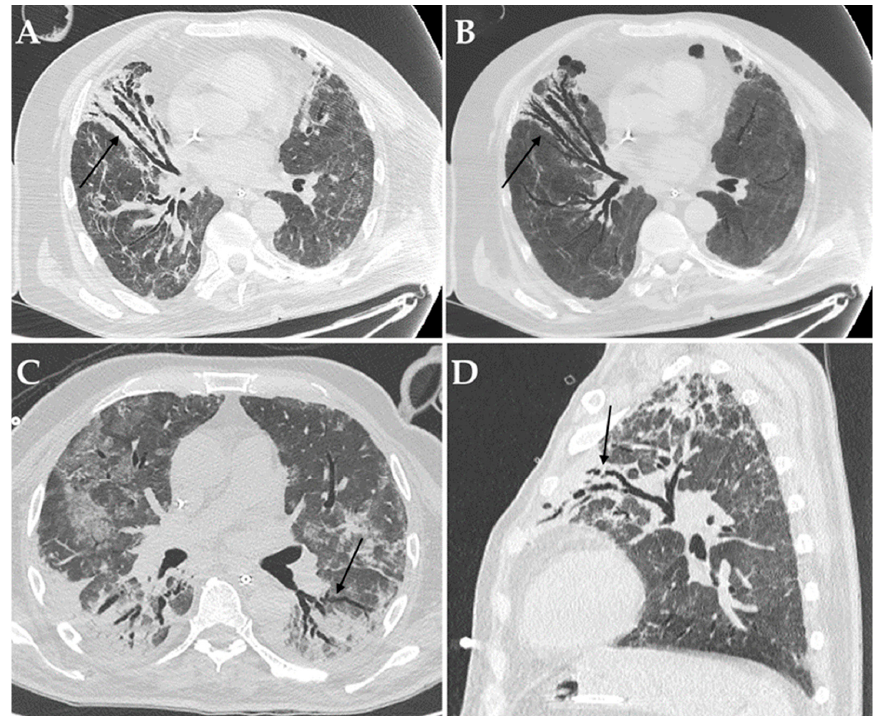
Figure 4. Axial HRCT images of a patient with COVID-19 ARDS admitted to ICU with bronchiectasis in the middle lobe (black arrow in ( A )), being more evident at Minimum Intensity Projection (MIP) reconstruction (black arrow in ( B )); Aspergillus niger was later detected in the bronchoalveolar lavage of the patient. Axial HRCT image of a different patient with COVID-19 ARDS with superinfection by Klebsiella pneumoniae and bronchiectasis in the dorsal segment of the left upper lobe (black arrow in ( C )). Sagittal HRCT image of a different patient with COVID-19 ARDS showing bronchiectasis in the left upper lobe (black arrow in ( D )) and presenting with elevated serum-galactomannan levels compatible with Aspergillus spp. superinfection.